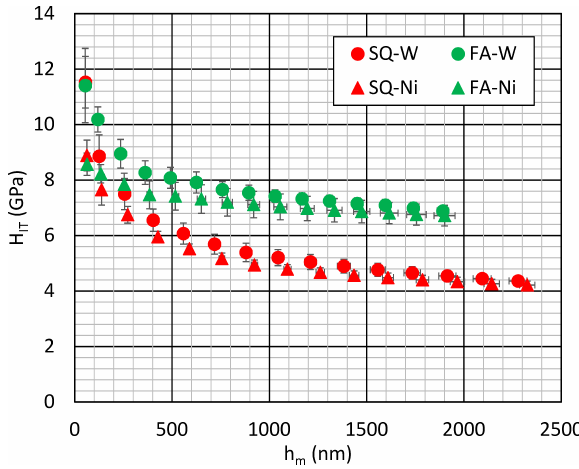
Figure 5. Hardness of W particles and Ni matrix determined by instrumented indentation by Berkovich indentor for different penetration depths h m . Figure 4. Crack growth rates da vs. the maximum dN stress intensity factor K max for sintered and quenched (SQ) and forged and annealed (FA) specimens.